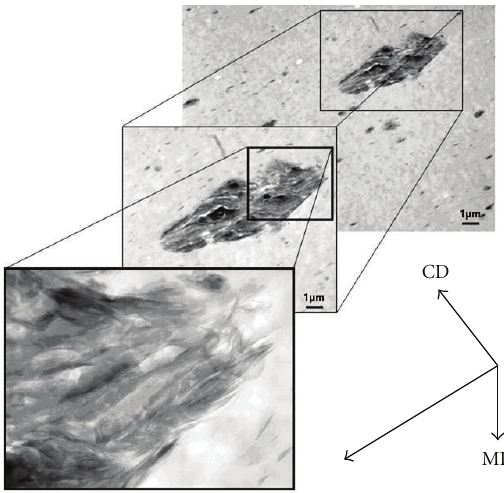
Figure 4: TEM image of nylon-6 film with 5wt% nanoclay.